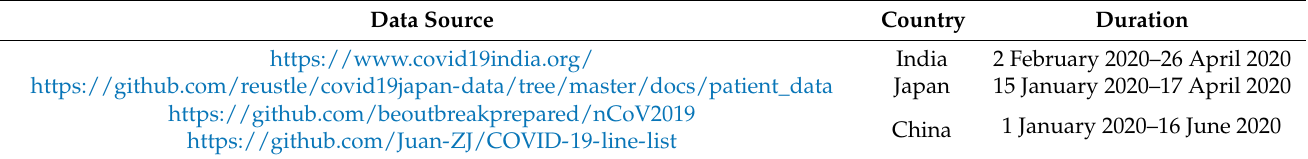
Table 1. Publicly available patient records databases used in this